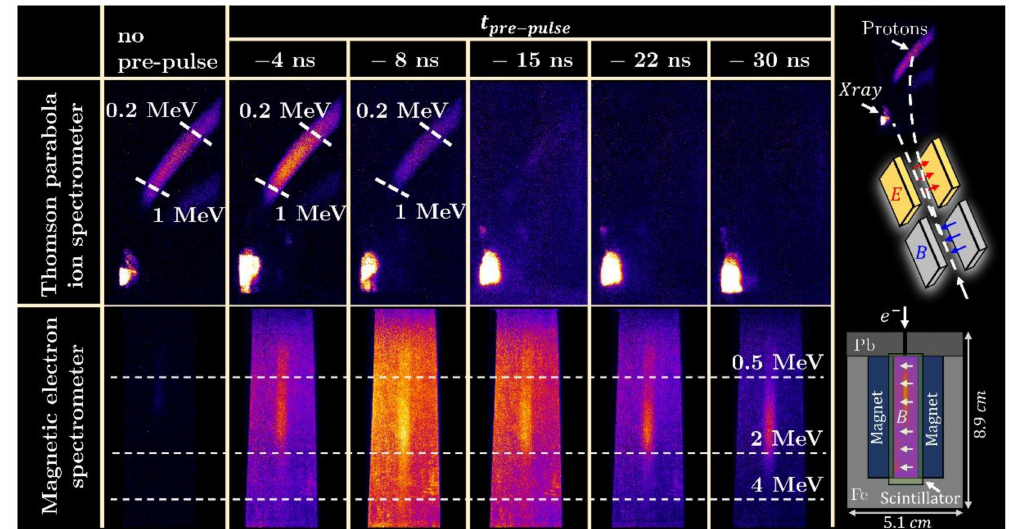
Figure 3. Raw ion ( top row ) and electron ( bottom row ) spectrograms obtained with different pre-pulse delays. The schematics of the two spectrometers are illustrated on the right.